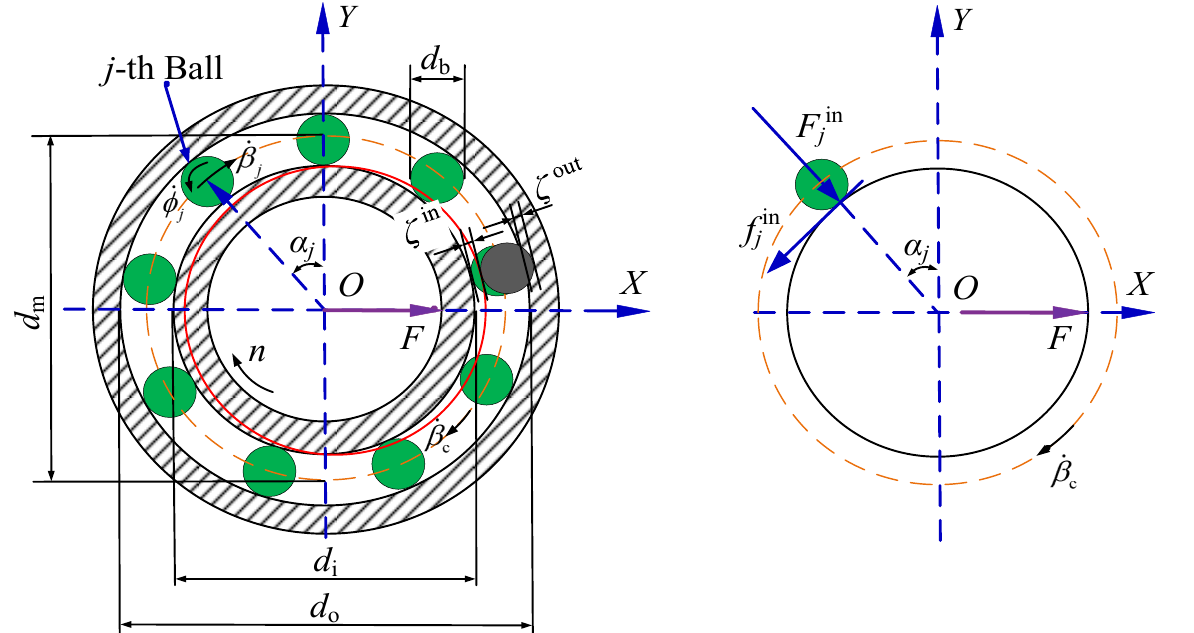
Figure 2. Kinematic relationship model of the DGB 6205 system.